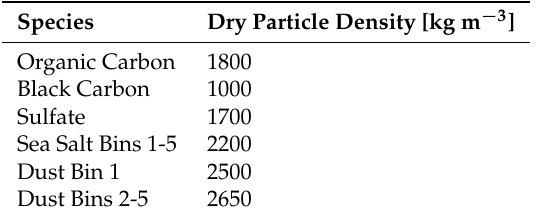
Table 7. Dry particle densities for the GOCART